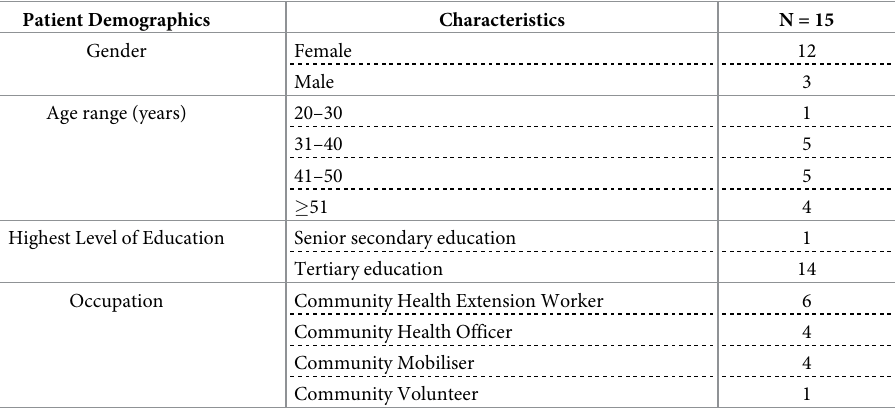
Table 1. Participant